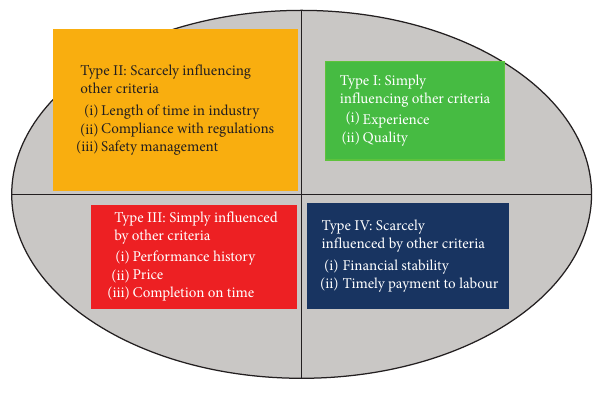
Figure 3: Quadrant